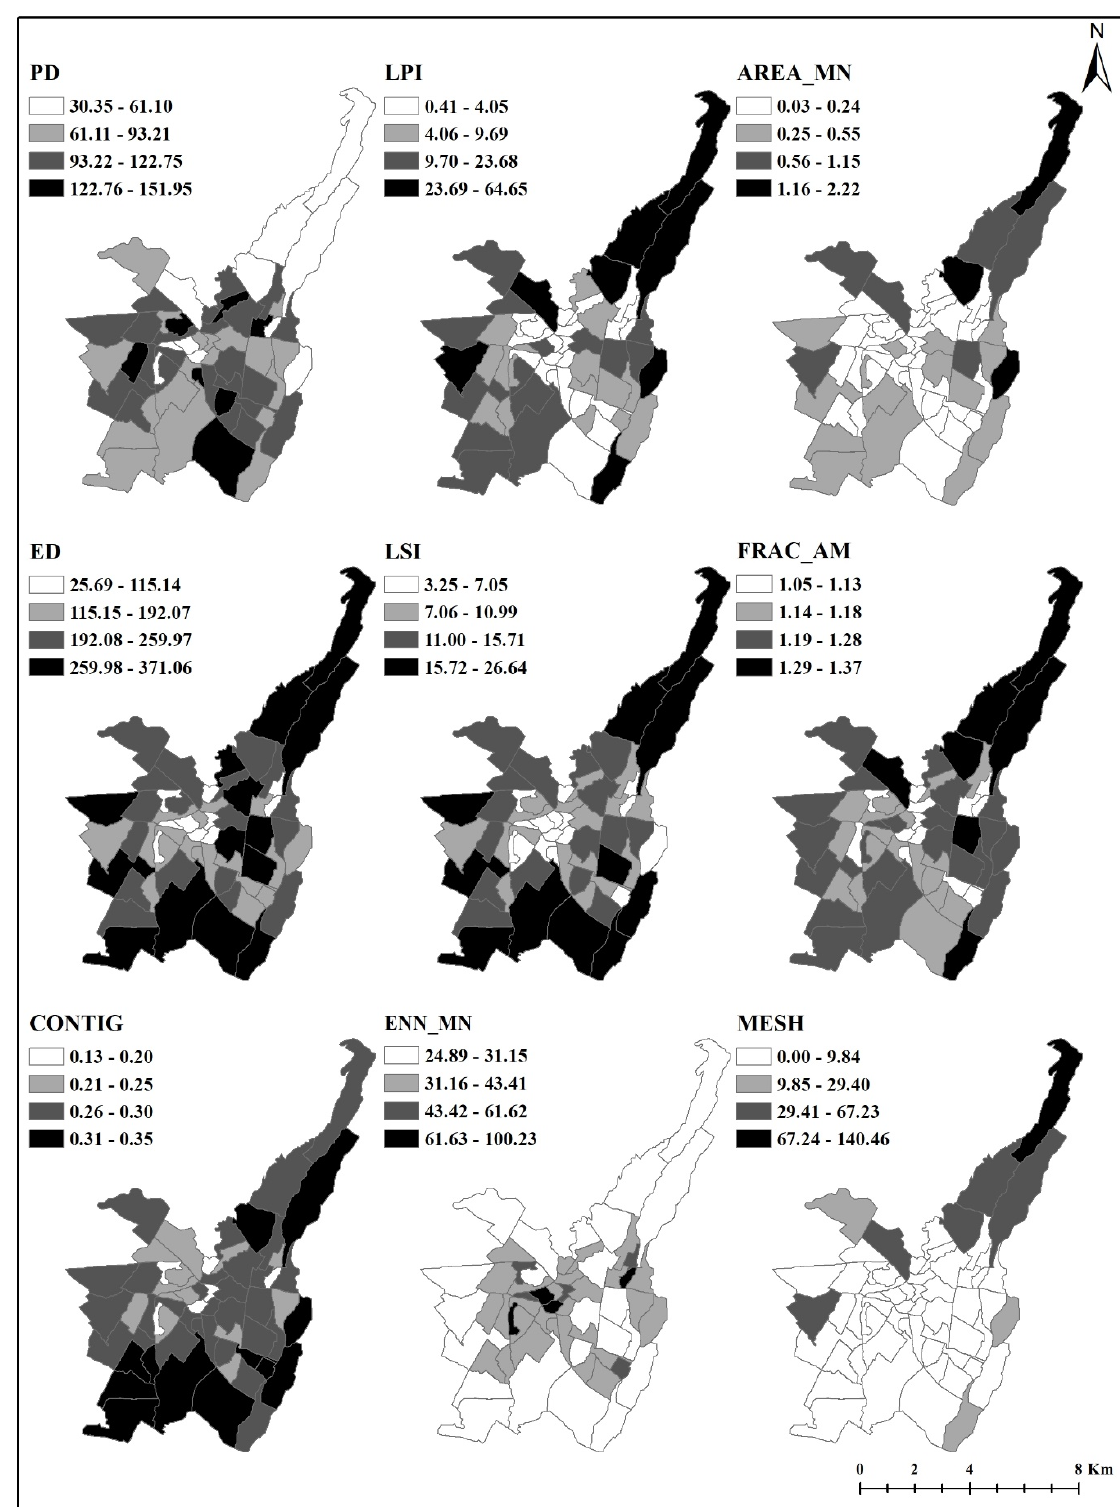
Figure 5. Spatial variation in landscape metrics by wards in Dehradun.